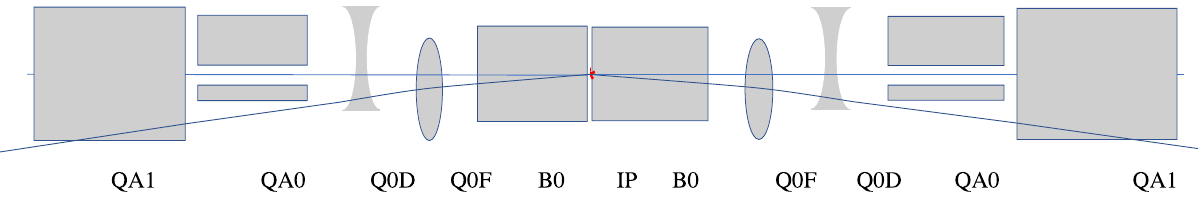
Fig. 14 Schematic view of the combined focusing and beam separation scheme